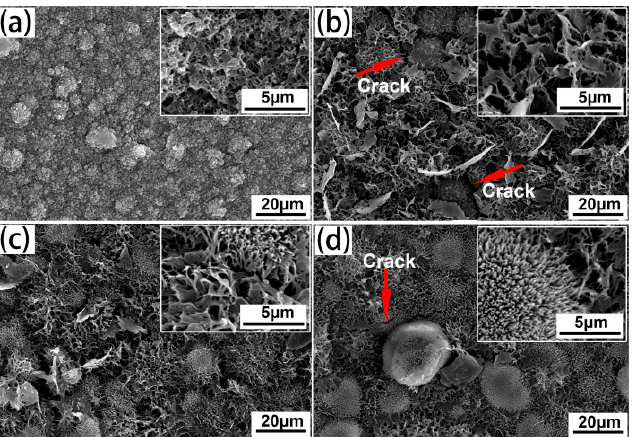
Figure 3. SEM images of the coatings prepared at 80 V with different deposition times: ( a ) 3 min, ( b ) 15 min, ( c ) 30 min, ( d ) 60 min. The insets show the corresponding high magnification images.